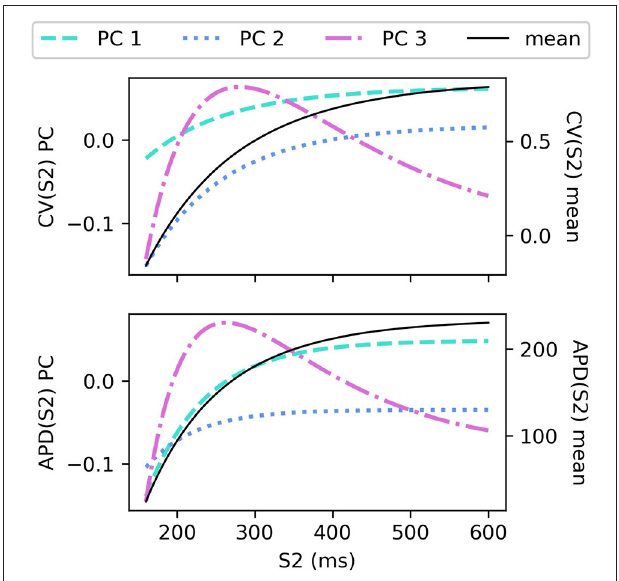
FIGURE 2 | PCA components and means for CV(S2) curves and APD(S2) curves for S1: 600 ms.